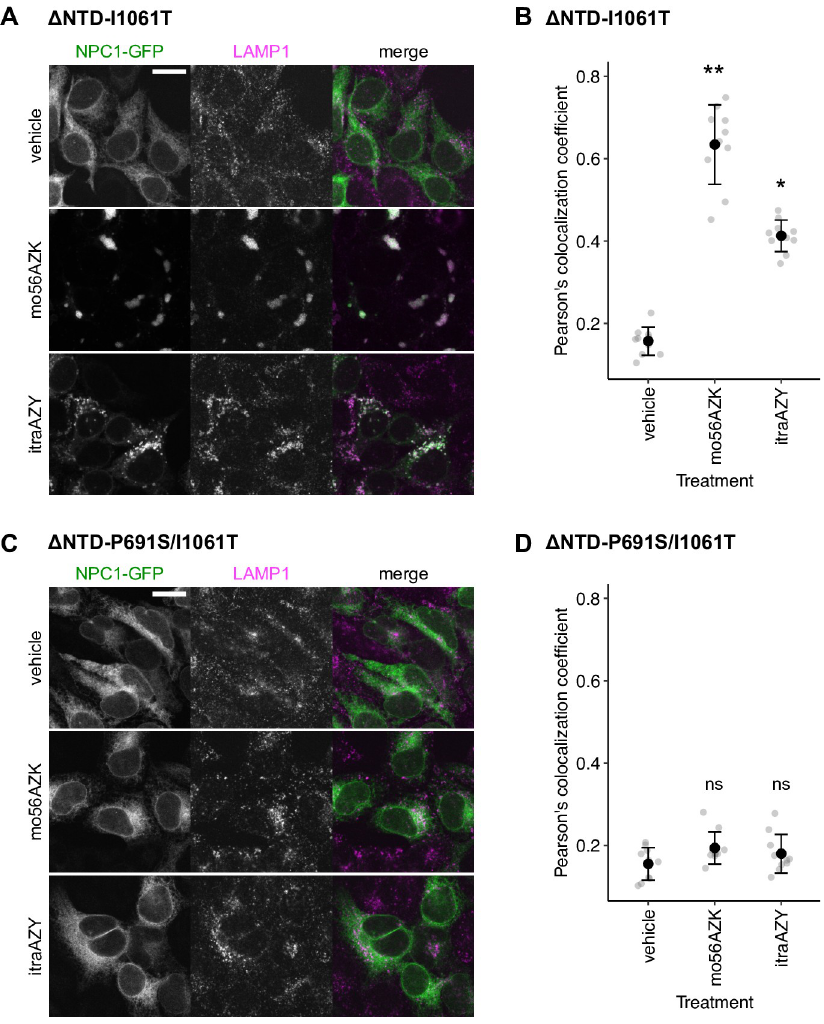
Fig 6. Chaperone effect of mo56HC and itraconazole is not affected by deletion of NTD but is abrogated by P691S mutation. (A) Colocalization of Δ NTD-NPC1-I1061T-GFP and LAMP1. Cells stably expressing Δ NTD-NPC1-I1061T-GFP were treated as indicated (1 μ M mo56AZK or 3 μ M itraAZY for 21 h). After LAMP1 immunostaining, images were acquired on a confocal microscope FV-3000 (Olympus) equipped with x60 objective lens. Scale bar, 50 μ m. (B) Quantitative colocalization analysis of Δ NTD-NPC1-I1061T-GFP and LAMP1. The filled black circles and error bars denote mean ± SD from 10 images, and gray points represent raw correlation coefficients obtained for each image. Statistical significance was evaluated by applying the Kruskal-Wallis rank sum test along with Dunn’s multiple comparison with the Benjamini-Hochberg-adjusted p value presented as � p < 0.05 and �� p < 0.01 (two- sided). (C) Colocalization of Δ NTD-NPC1-P691S/I1061T-GFP and LAMP1, performed as in (A). (D) Quantitative colocalization analysis of Δ NTD-NPC1-P691S/I1061T-GFP and LAMP1 performed as in